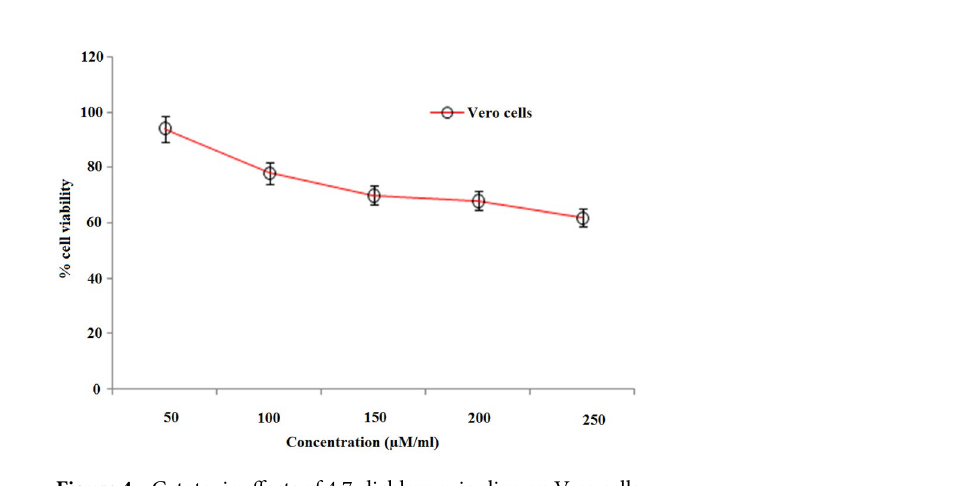
Figure 4. Cytotoxic effects of 4,7-dichloroquinoline on Vero